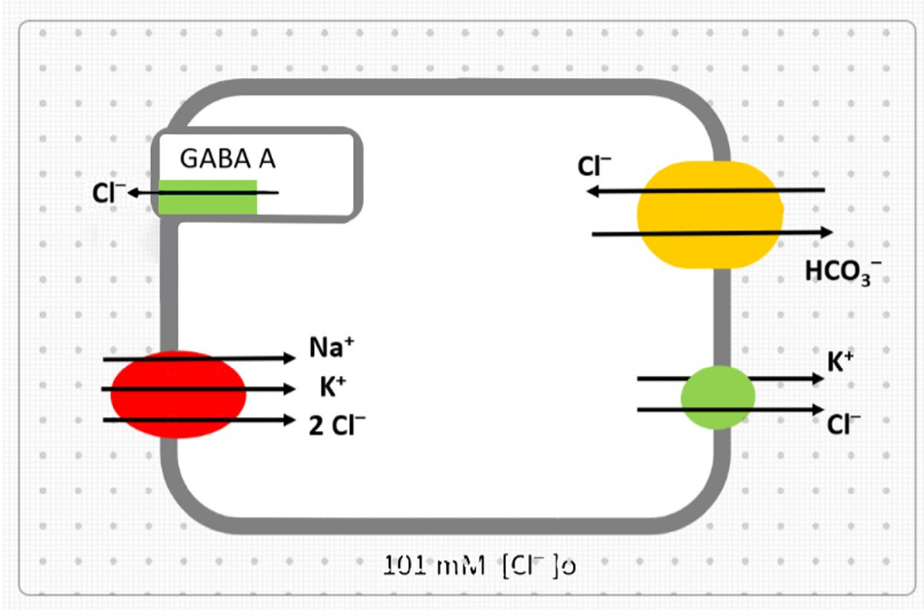
Figure 1. Mechanisms of Cl − transport in glioblastoma cell and possible effects of VPA. The Na + -K + - 2Cl − co-transporter activity (Cl − influx) is elevated in the glioblastoma cell, and the drug should inhibit this transport. The activity of the K + -Cl − co-transporter (Cl − efflux) is blunted (the target effect of the treatment is to activate the carrier). The activity of the latter carrier stimulates the activity of the GABA A receptor, which is a Cl − channel transporting Cl − out of the cell. As the concentration of [Cl − ]i in the glioblastoma cell is significantly increased, the resulting Cl − concentration gradient makes the Cl − /HCO 3 − exchanger inactive. It is expected that the VPA can perform the necessary regulation of Cl − transport across cell membrane according to the markings in figure traffic light colors.